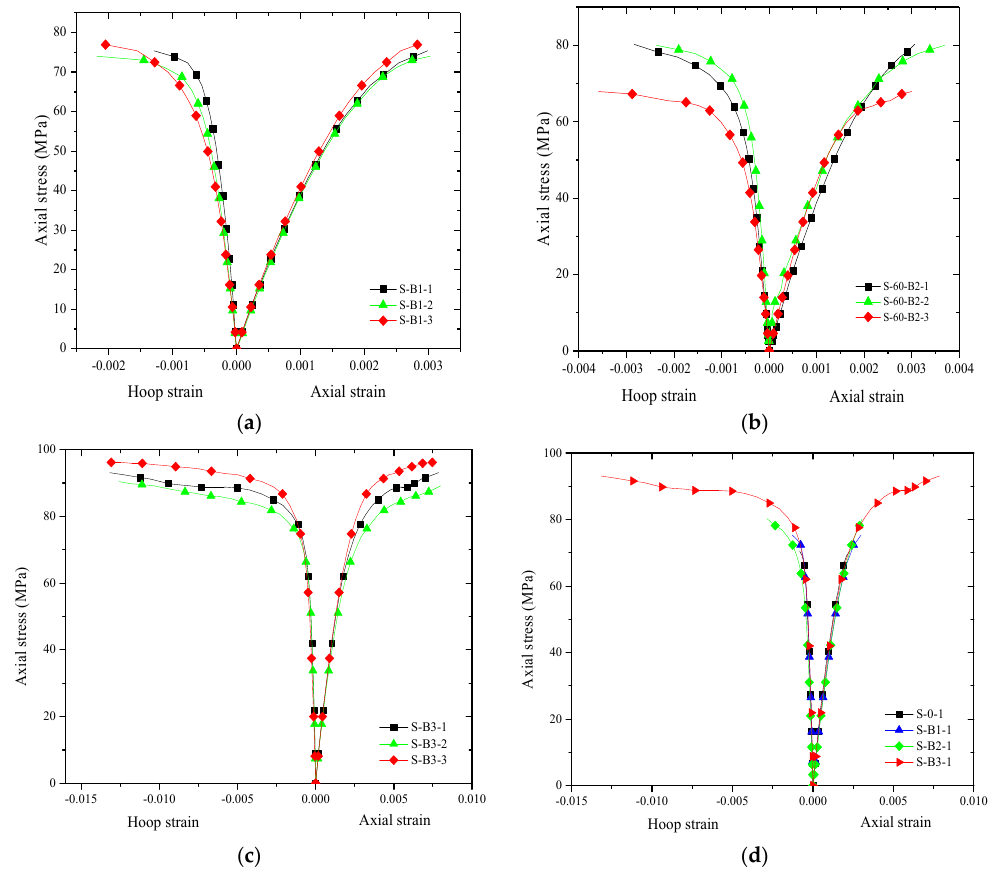
Figure 5. Stress–strain curves of the BFRP-confined concrete specimens under quasi-static compression. ( a ) One-layer BFRP-confined specimens; ( b ) Two-layer BFRP-confined specimens; ( c ) Three-layer BFRP-confined specimens; and ( d ) BFRP-confined and unconfined